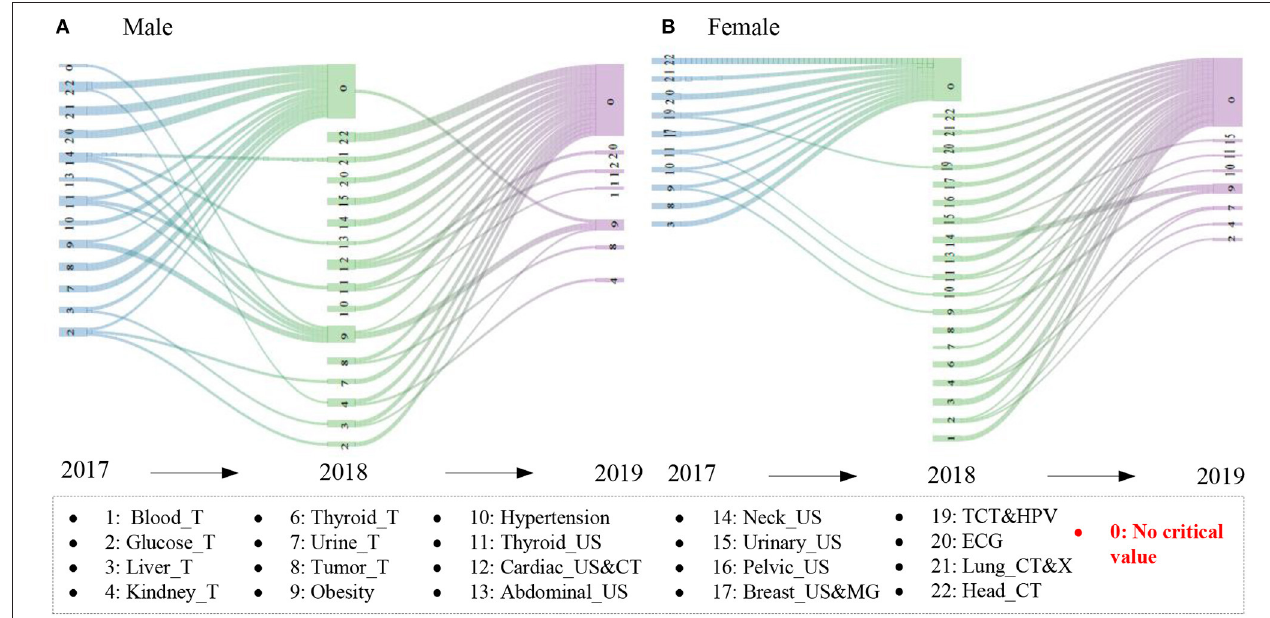
FIGURE 6 | The effective evolution paths for men and women. 2017 → 2018 and 2018 → 2019 denote the same participants with at least one critical value in 2017 and 2018 and 2018 and 2019, respectively. The critical values were shown when the transition probability exceeded